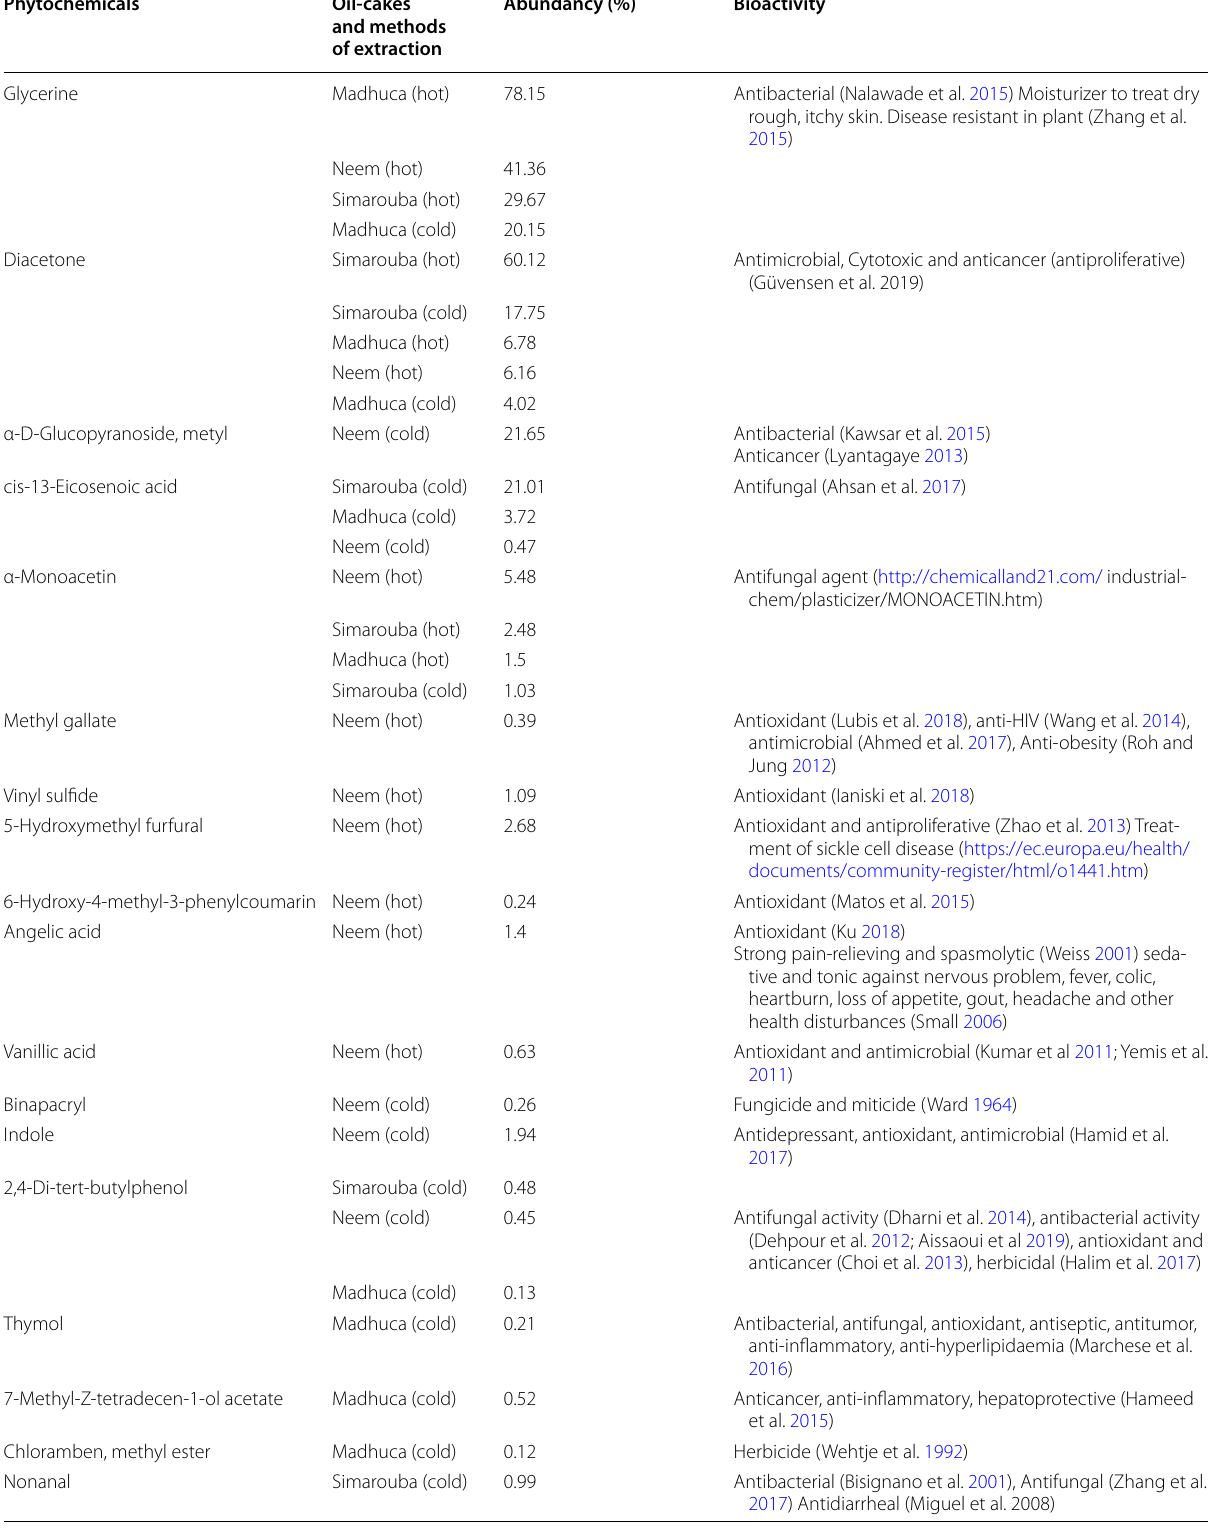
Table 3 GCMS profile of acetone extracts of oil-seed cakes of neem, madhuca, and simarouba with bioactivity